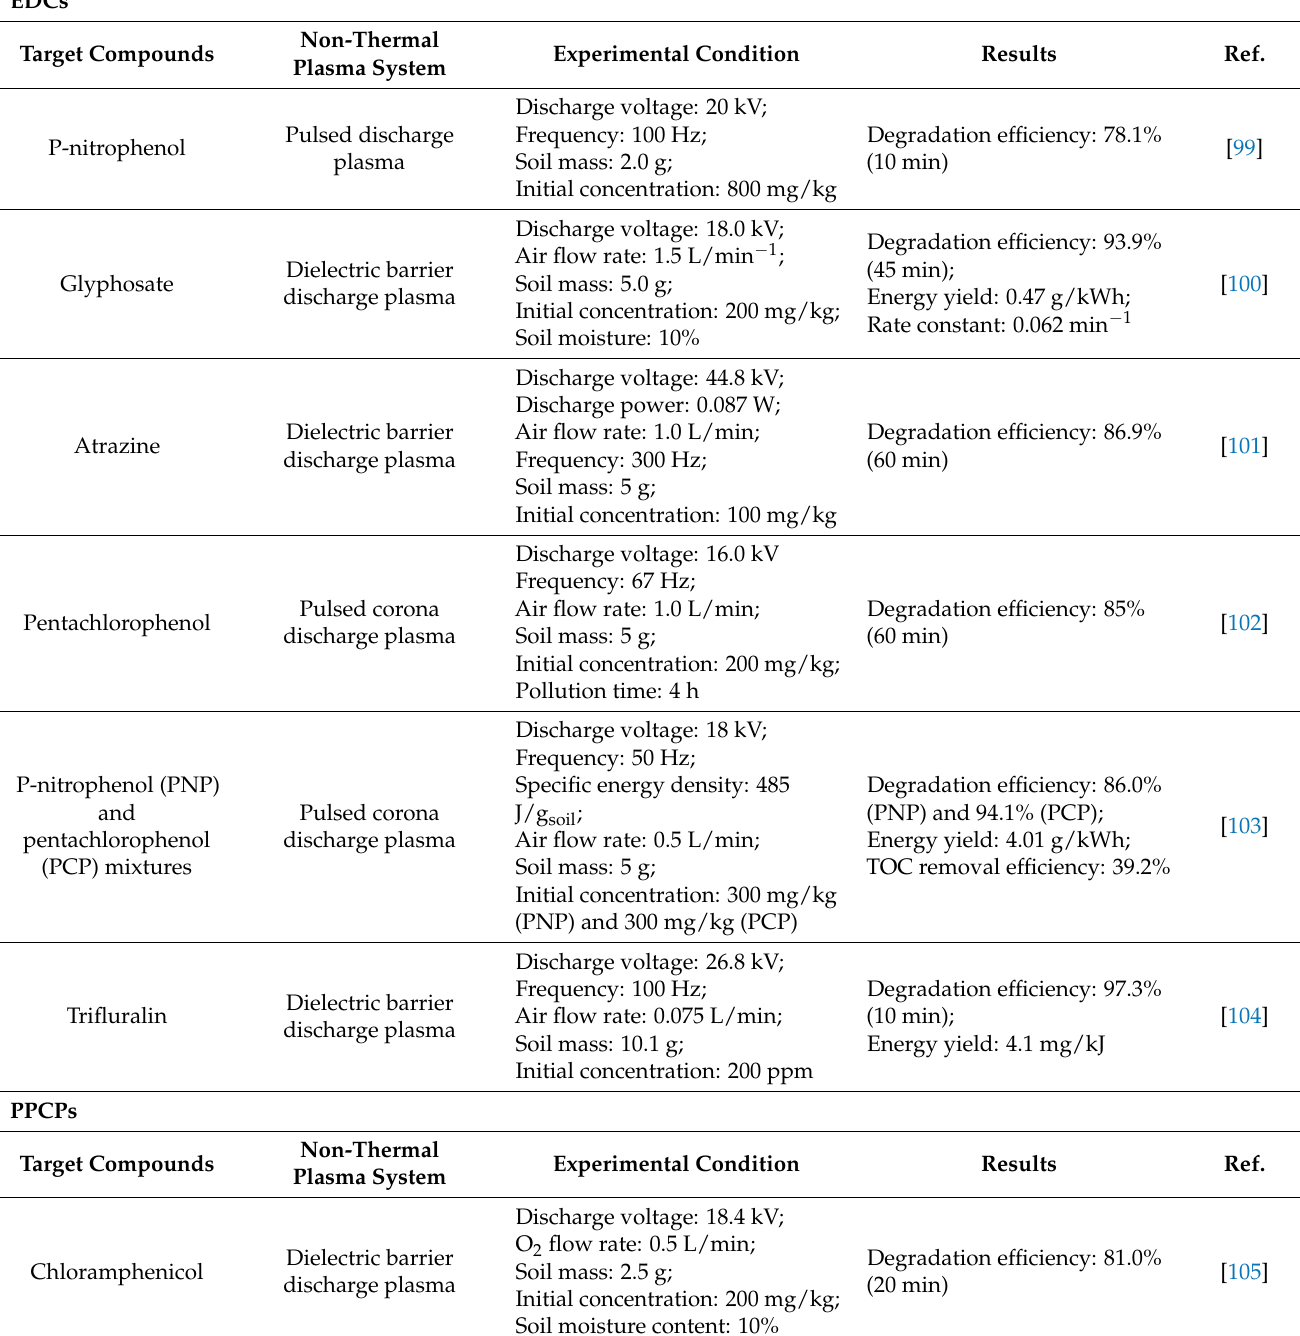
Table 2. Overview of work done in the degradation of EOPs in soil by non-thermal